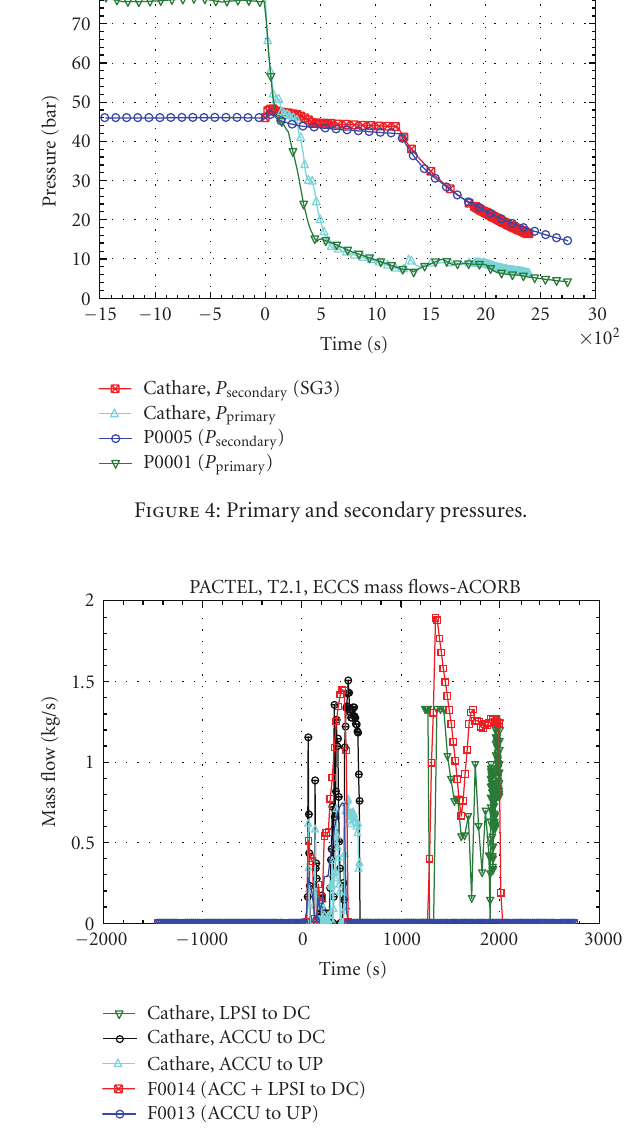
Figure 5: ECCS mass